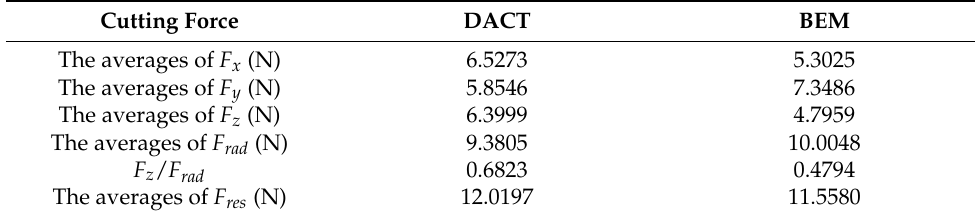
Table 2. Cutting force